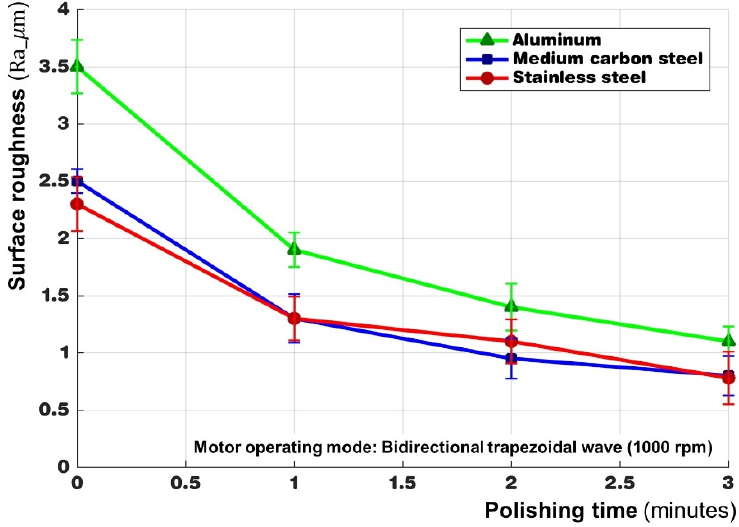
Figure 8. Comparison chart of average material removal weight and polishing time at three motor speeds.